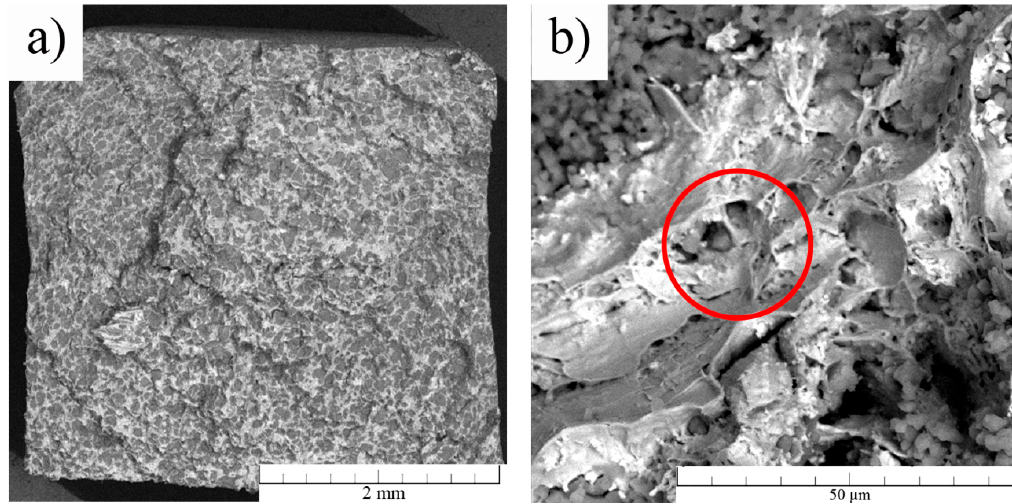
Figure 6. ( a ) Fracture surface of the extruded Zn / HA8 composite. ( b ) Detail of the fracture surface with signs of plastic deformation (circled in red).